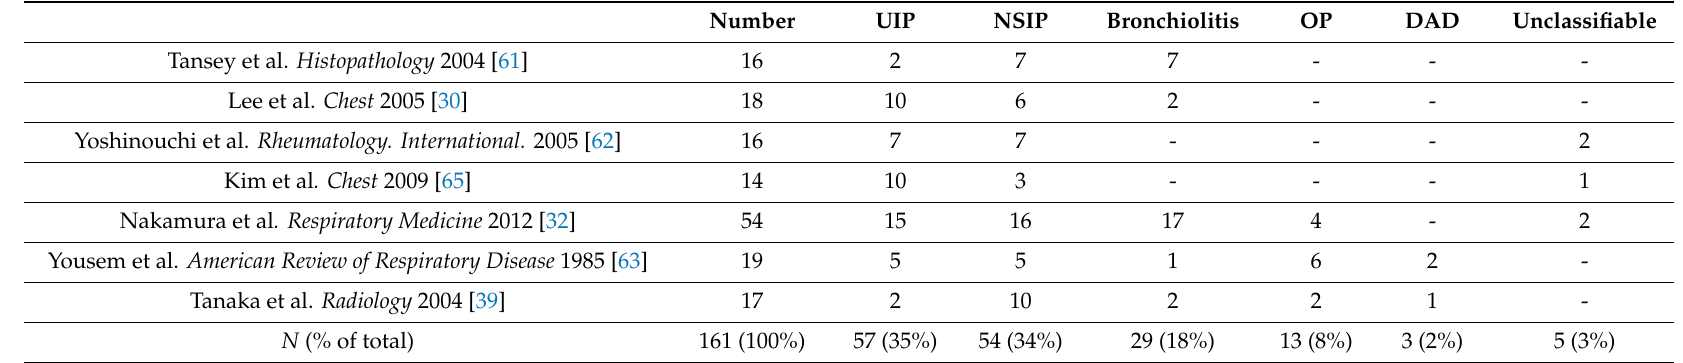
Table 2. Histopathological patterns from surgical lung biopsy and autopsy materials in patients with RA-ILD. UIP: usual interstitial pneumonia, NSIP: non-specific interstitial pneumonia, OP: organizing pneumonia, DAD: di ff use alveolar